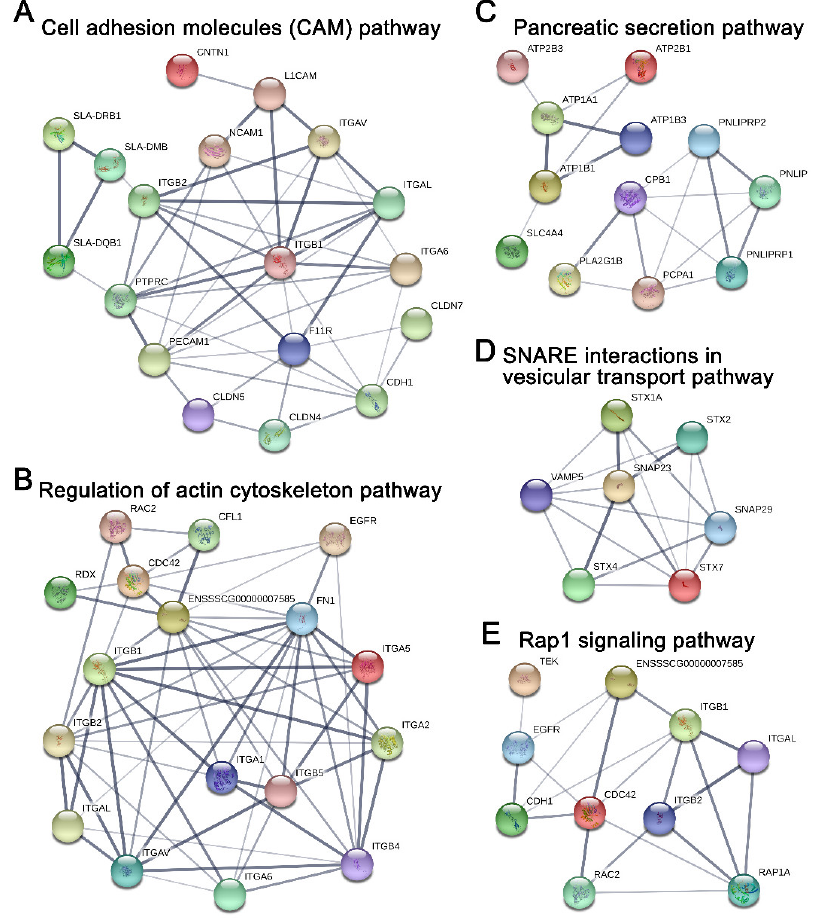
Figure 7. Association networks of the proteins in the enriched pathways identified from young dpECM proteins detected. ( A ) Cell adhesion molecule pathway. ( B ) Regulation of actin cytoskeleton pathway. ( C ) Pancreatic secretion pathway. ( D ) SNARE interactions in vesicular transport pathway. ( E ) Rap1 signaling pathway. The altered colors stand for different proteins. Line thickness represents the degree of supporting data from publications. Due to the difference in the annotations of protein identities in the DAVID and STRING databases, PCPA1 in ( B ) refers to carboxypeptidase A1 (CPA1); ENSSSCG00000007585 in ( B , E ) refers to actin β (ACTB).